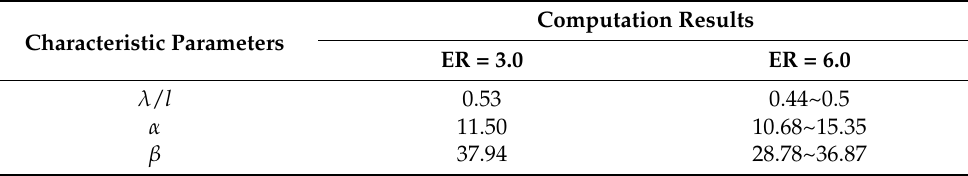
Table 1. Cell characteristic parameters under different ER obtained by numerical calculation. Characteristic